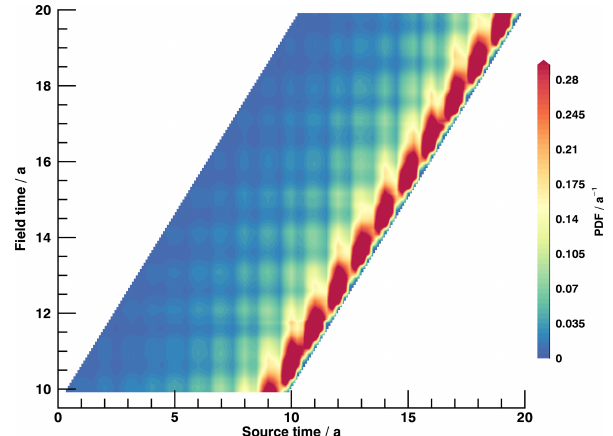
Figure 2. Exemplary BIR map for the analyzed time span of the EMAC simulation at 55 ◦ N and 70hPa. Source time represents the date when a specific pulse tracer is initialized, while field time is the progressive time of the model simulation. The amount fraction of the PDF is color coded.